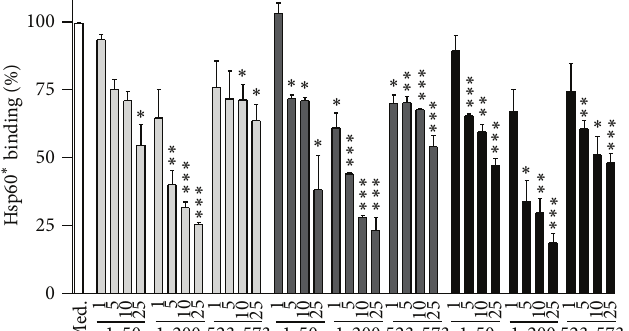
Figure3:IdentificationofHsp60bindingregionsbyHsp60epitope-specificantibodies.Increasingconcentrations(0–25 𝜇 g/mL)ofantibodies directedagainstdistinctaminoacid(aa)regionsoftheHsp60moleculewereincubatedwith100 nMDylight649-labeledHsp60(Hsp60 ∗ )prior addition to C57BL/6J, NOD, or NZO mouse-derived preadipocytes. The resulting fluorescence signals of the cells were determined by FACS analysis. The data show residual Hsp60 ∗ binding to C57BL/6J (light grey bars), NOD (dark grey bars), and NZO mouse-derived cells (black bars) as percent of the binding of Hsp60 ∗ to cells cultivated in medium (Med.) in the absence of antibodies (set as 100%, white bar). The data represent means + SEM of three independent experiments. ∗ 𝑃 < 0.05 ; ∗∗ 𝑃 < 0.01 ; ∗∗∗ 𝑃 < 0.001 compared to the binding of Hsp60 ∗ alone.